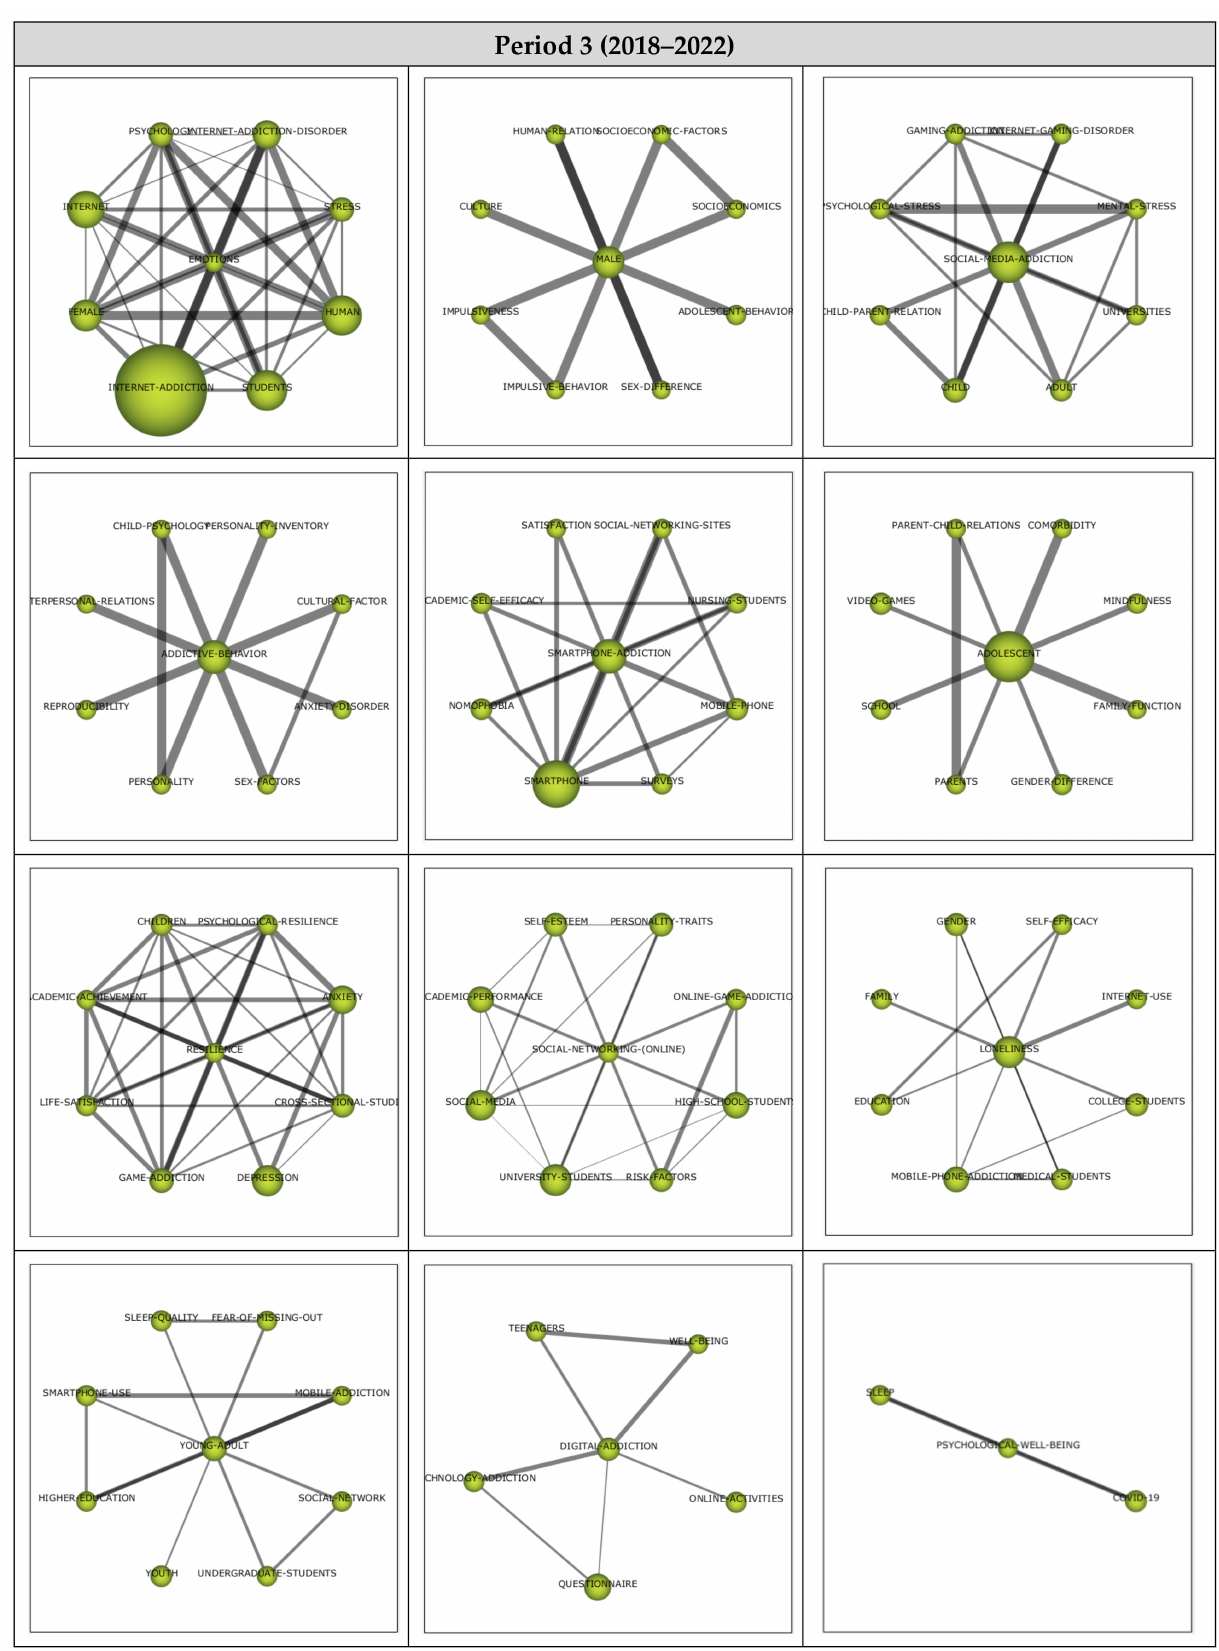
Figure 9. Period 3: Thematic network